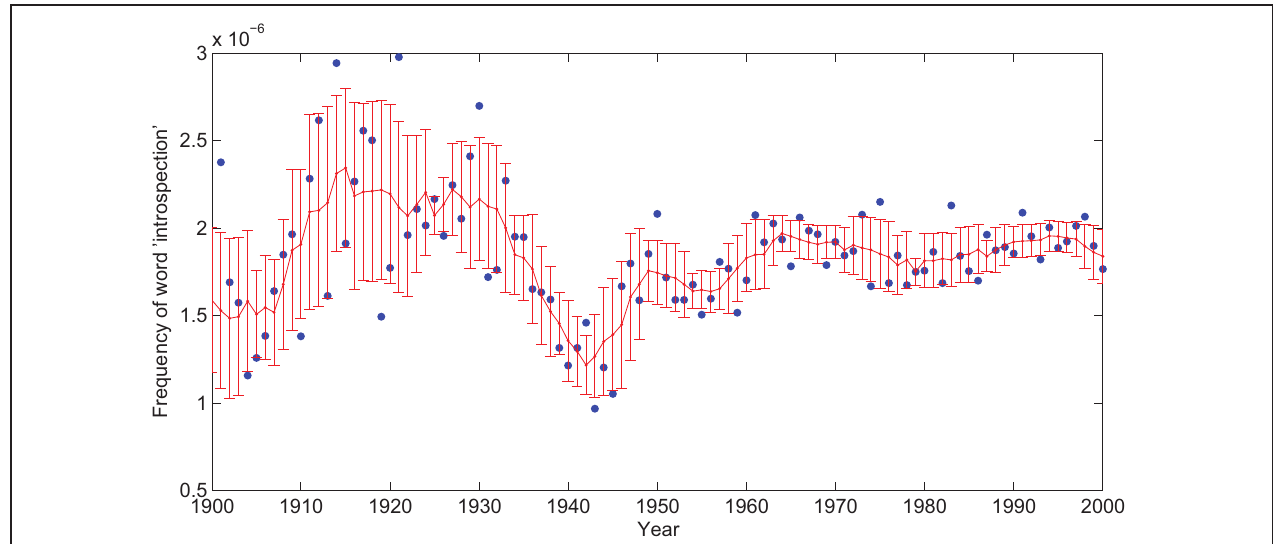
FIGURE A1 | Frequency of the term “instrospection” on Google n–grams in the twentieth century. The blue points correspond to frequency of the word introspection, and the red bars indicate the mean and standard deviation of the null hypothesis.